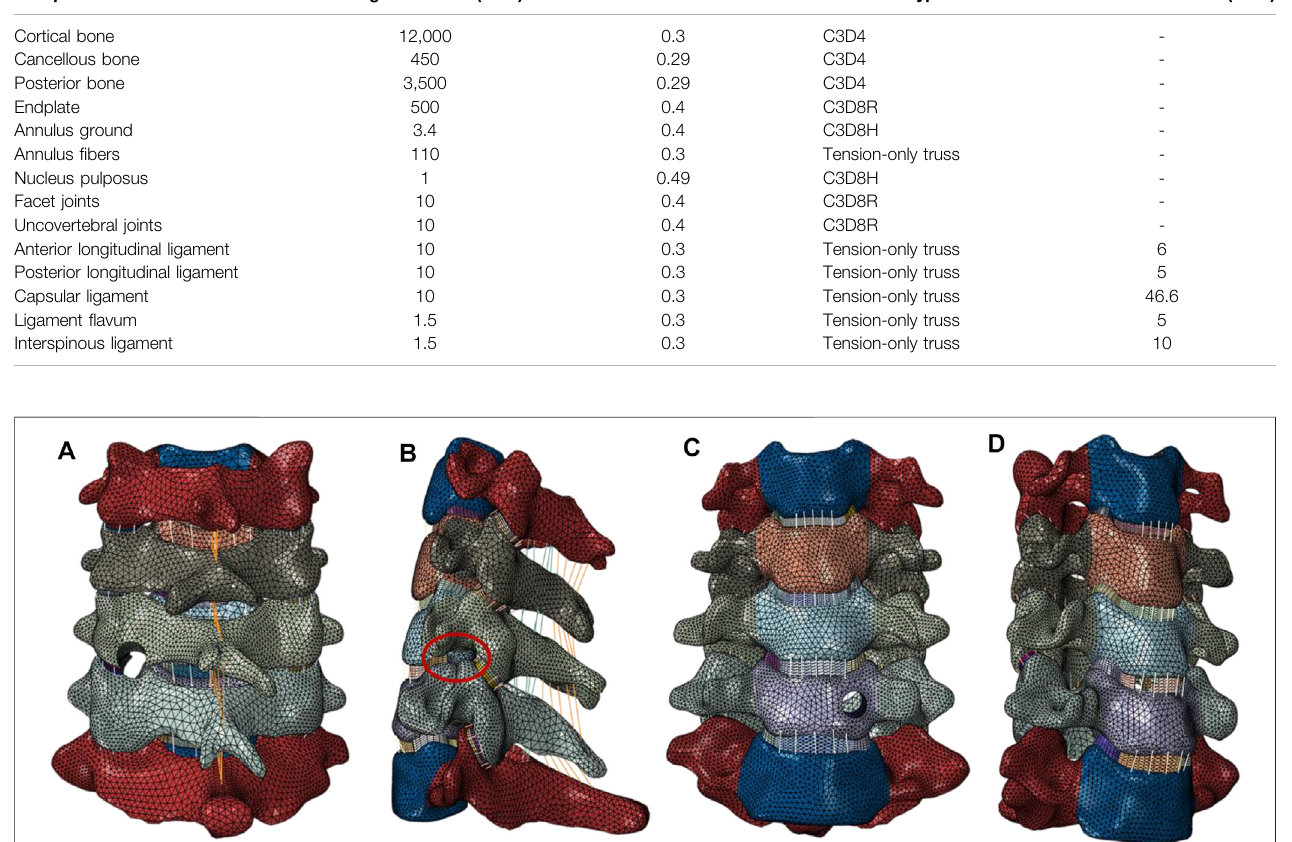
TABLE 1 | The mechanical property of the components of the C3 – C7 fi nite element model. Components